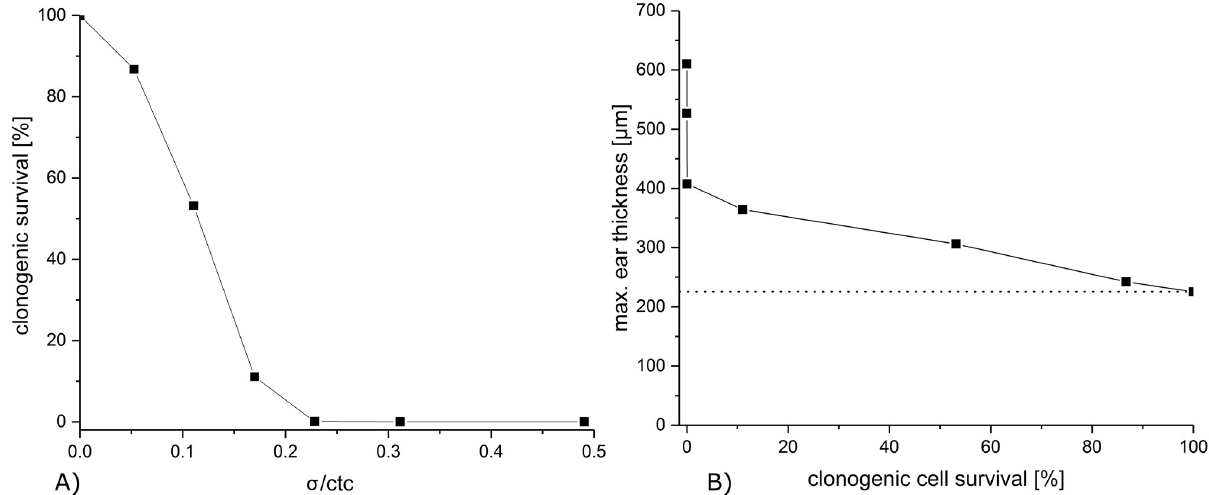
Thus, the number of proliferating cells may not be the only parameter that determines the radiation responses. Cells irradiated with hundreds of Gy may not only be stopped from prolif- erating but may have a higher probability of necrosis or apoptosis, which in turn alters the tis- sue repair. Furthermore, migration of viable cells adjacent to the minibeams needs to be taken into account for tissue repair, which is again dependent on the size of the radiation-injured area. However, detailed models are missing to calculate the cell death pathway fractions for dif- ferent doses as they appear in the inhomogeneous dose distributions of spatial fractionation.